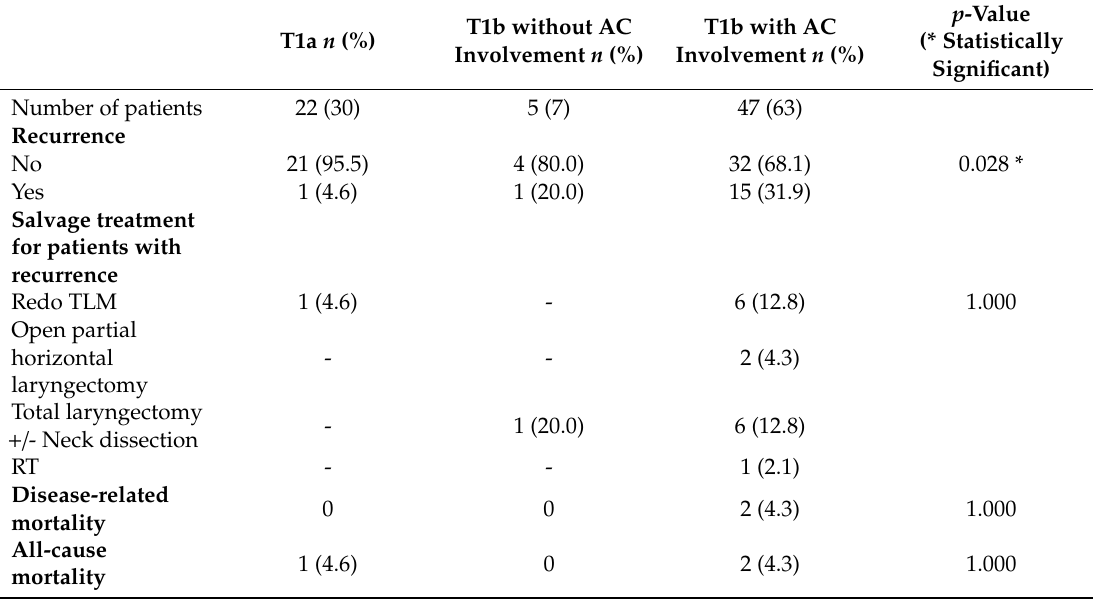
Table 2. Disease recurrence and mortality